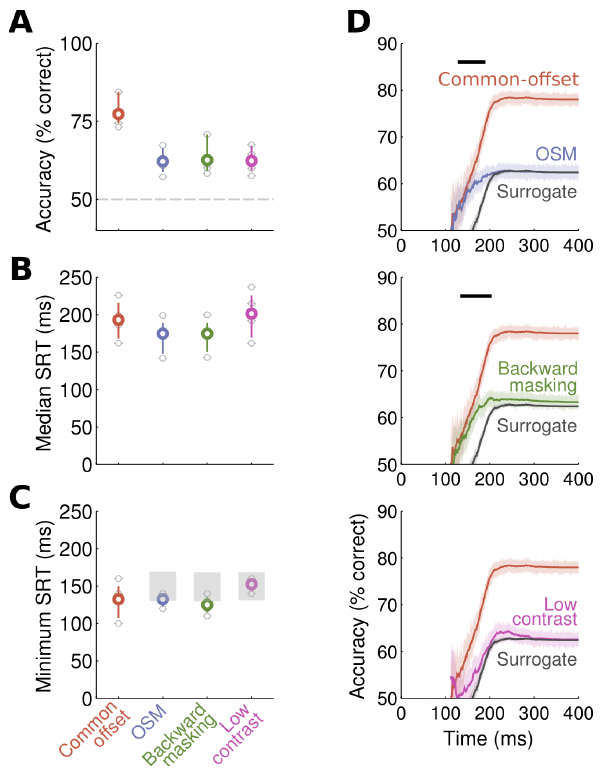
Figure 2. Accuracy and saccadic reaction times (SRT) results. ( A ) Accuracy averaged across observers (colored circles) in the four conditions and corresponding 95% CI. Light gray circles indicate results of individual observers. Note that target contrast was adjusted in the three low-visibility conditions to yield 60% accuracy. ( B ) Average and single-observer Median SRT. Same conventions as in (A). Median SRT were comparable in all conditions. ( C ) Average and single-observer Minimum SRT, computed as the fastest SRT at which accuracy was above chance level. Same conventions as in (A). For each low-visibility condition, superimposed light gray areas correspond to the 95% CI of the surrogate condition computed by swapping the correctness of trials from the common-offset condition until it matched the accuracy in the three low-visibility conditions. Minimum SRT for OSM and backward masking, but not for low-contrast, were significantly faster than expected based on the surrogate condition. ( D ) Accuracy time-course, obtained from the cumulative SRT distributions for correct and incorrect responses pooled across all observers (shaded areas correspond to 95% CI). For better readability, latencies before 110 ms are not displayed because not enough data were available to get a reliable measurement of accuracy. Horizontal black lines on top represent the time points at which the observed accuracy time-course in the three low-visibility conditions was significantly different from the surrogate time-course (obtained from the same resampling as in (C); non-parametric bootstrap test). Note that the fastest saccades under OSM and backward masking, but not for low-contrast, were as accurate as similarly fast saccades without masking (red trace) and significantly more accurate than predicted by the surrogate condition.